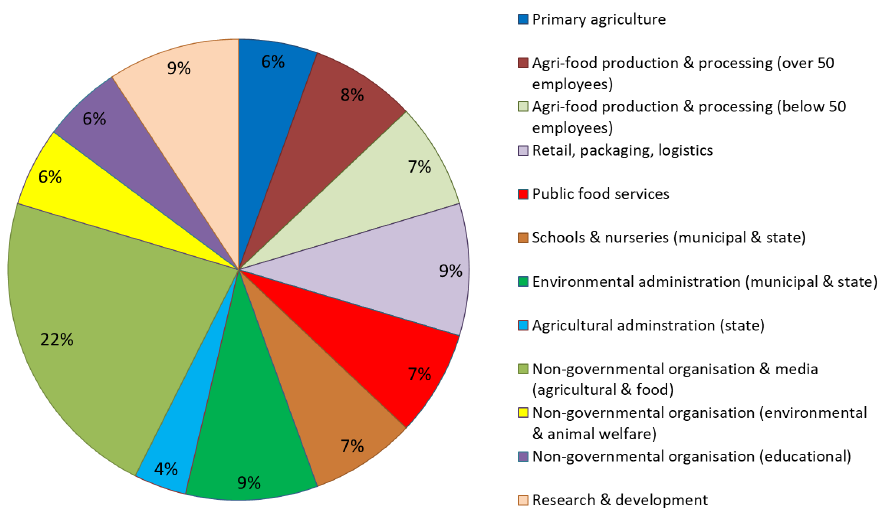
Fig. 1. Respondents of the survey according to the different sectors in